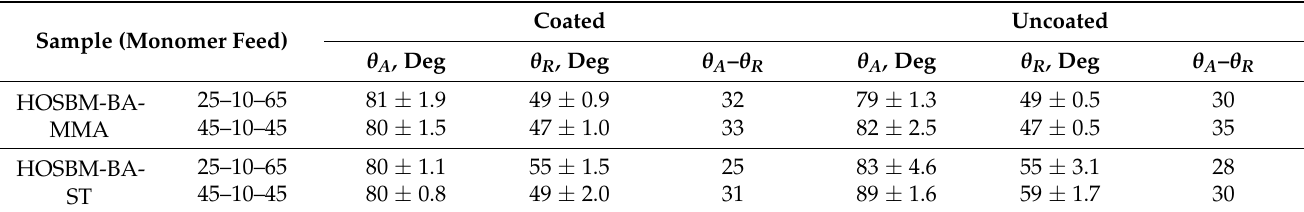
Table 4. Contact angle hysteresis of HOSBM-based latexes on coated/uncoated paperboard.